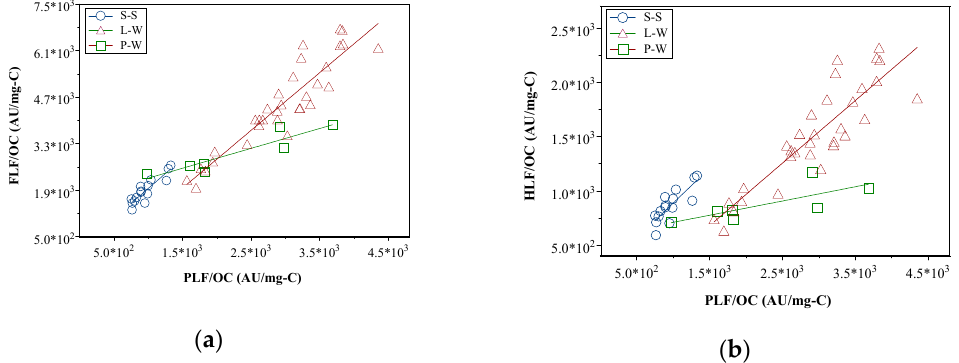
Figure 5. The linear regression of OCS FLF to OCS PLF ( a ) and OCS HLF to OCS PLF ( b ).